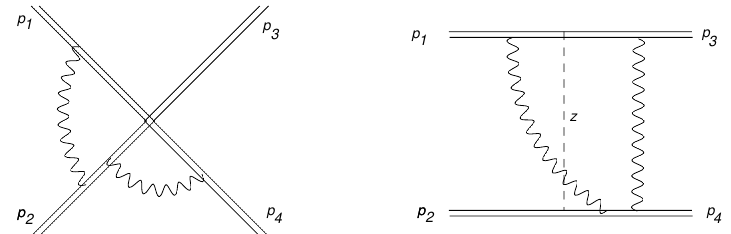
Figure 3 . Sample diagrams for the VEV in eq. (5.1) (left) and eq. (5.4) (right). Wilson lines and gravitons are denoted with double lines and wavy lines, respectively. The dashed line in the right diagram splits each Wilson line in two branches to distinguish initial and final states of the leading order amplitude, where two highly energetic particles are separated by an impact parameter z